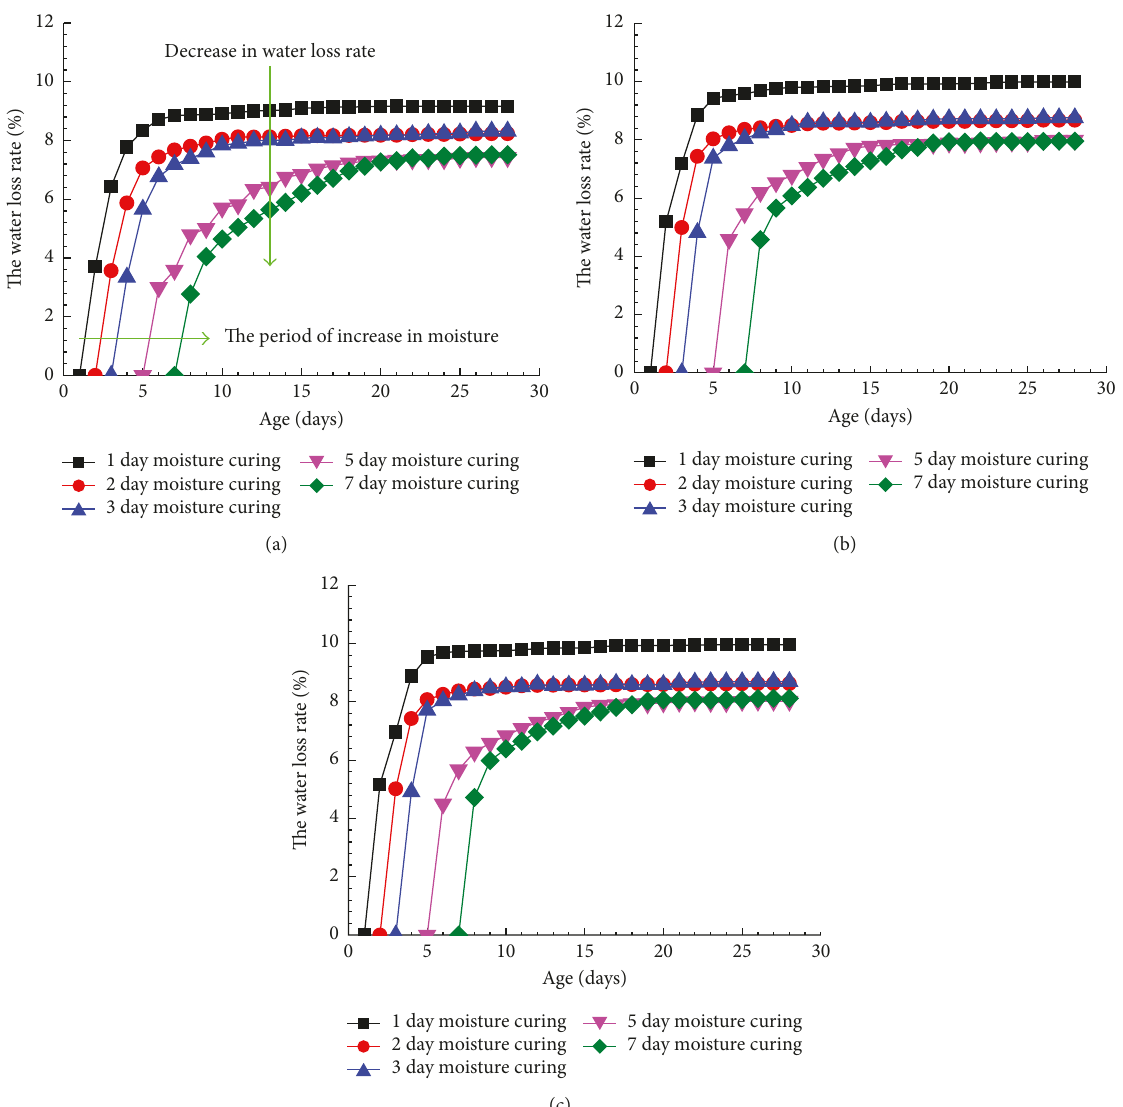
Figure 6: The water loss rate with different wind speeds. (a) 0 m/s. (b) 4m/s. (c)